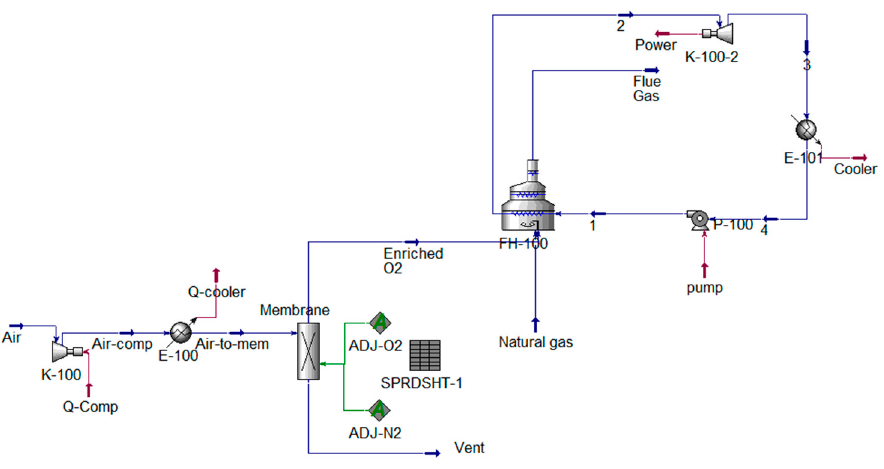
Figure 5. UniSim simulation of the Alzour power plant using enriched oxygen of 30 mol% by a membrane unit.